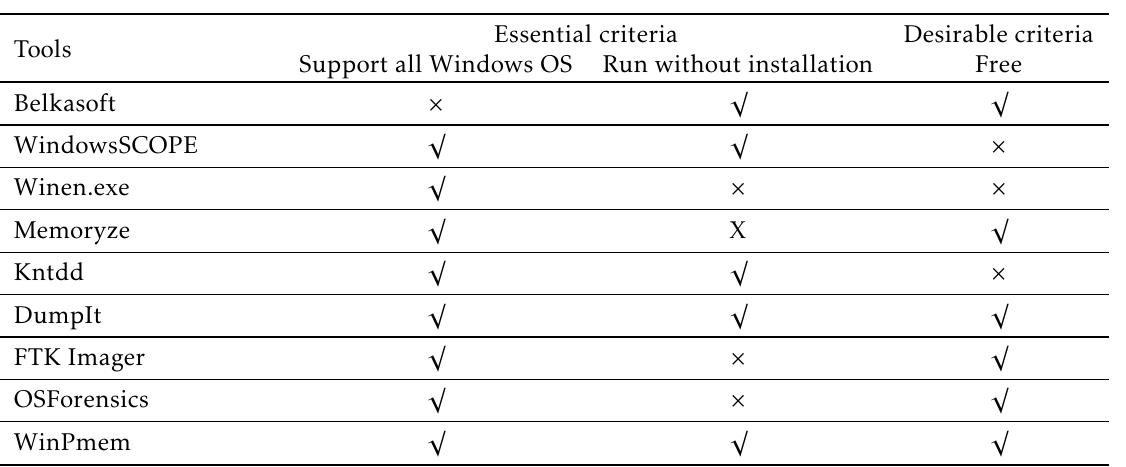
Table 1. Essential and the desirable criteria of acquisition tools